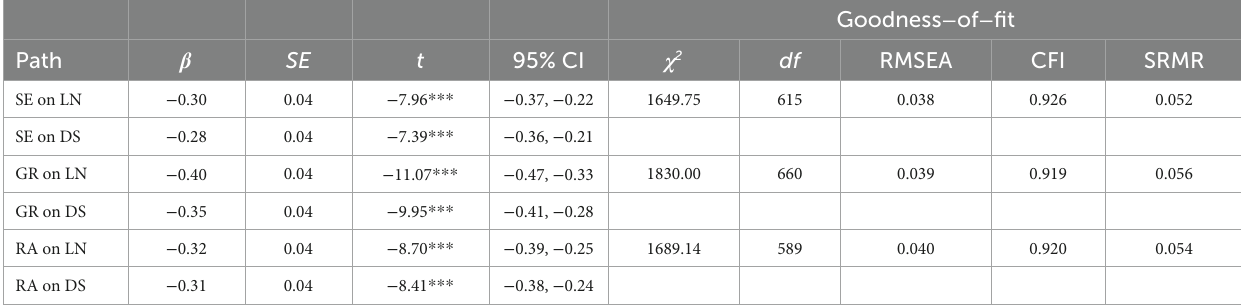
TABLE 5 Main effect of group orientations on mental health problems.